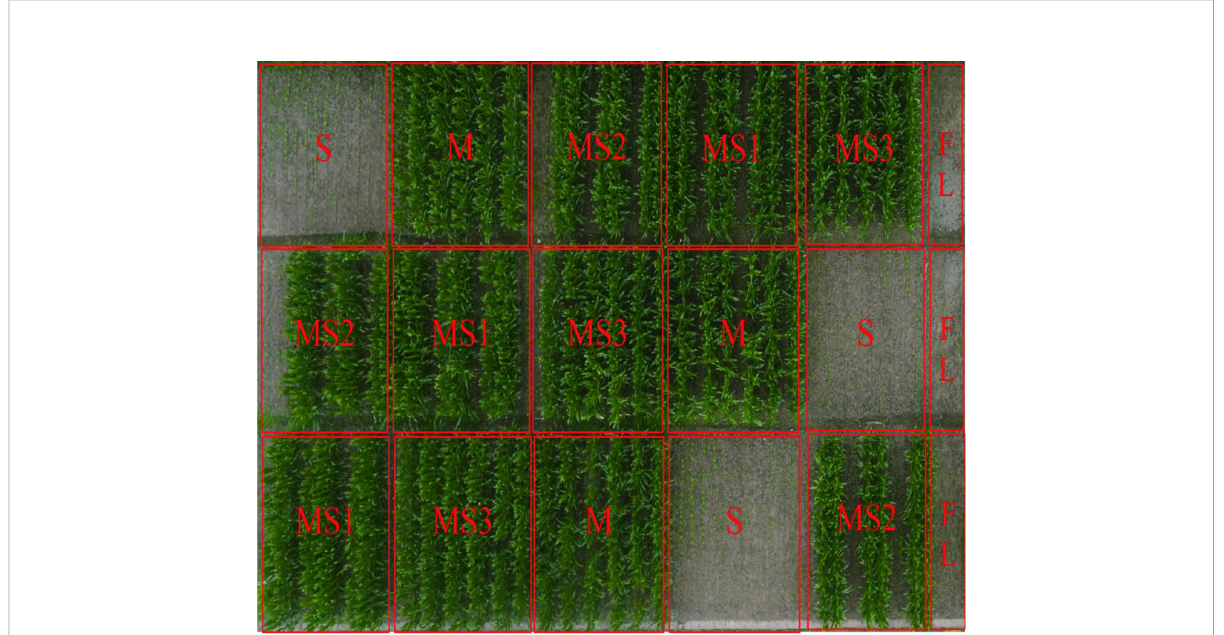
FIGURE 1 Location of the research site aerial photo. Note: MS1, MS2, MS3, M, S, FL represent the Continuous planting of maize/soybean relay strip intercropping, Planting of maize/soybean relay strip inter-cropping in rotation, Traditional maize/soybean inter-cropping, Sole maize planting, Sole soybean planting, Fallow land,